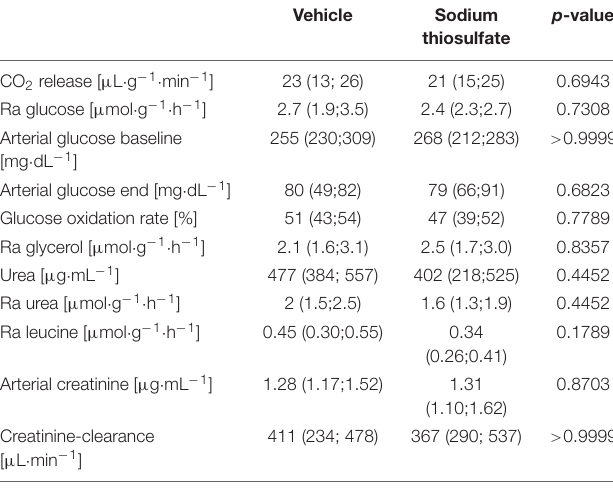
TABLE 2 | Terminal stable isotope-based metabolic flux and organ function parameters.